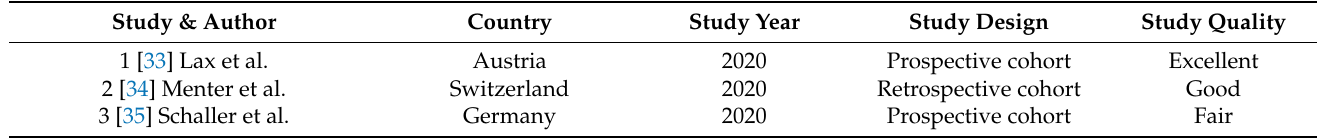
Table 1. Study Table 1. Study characteristics.